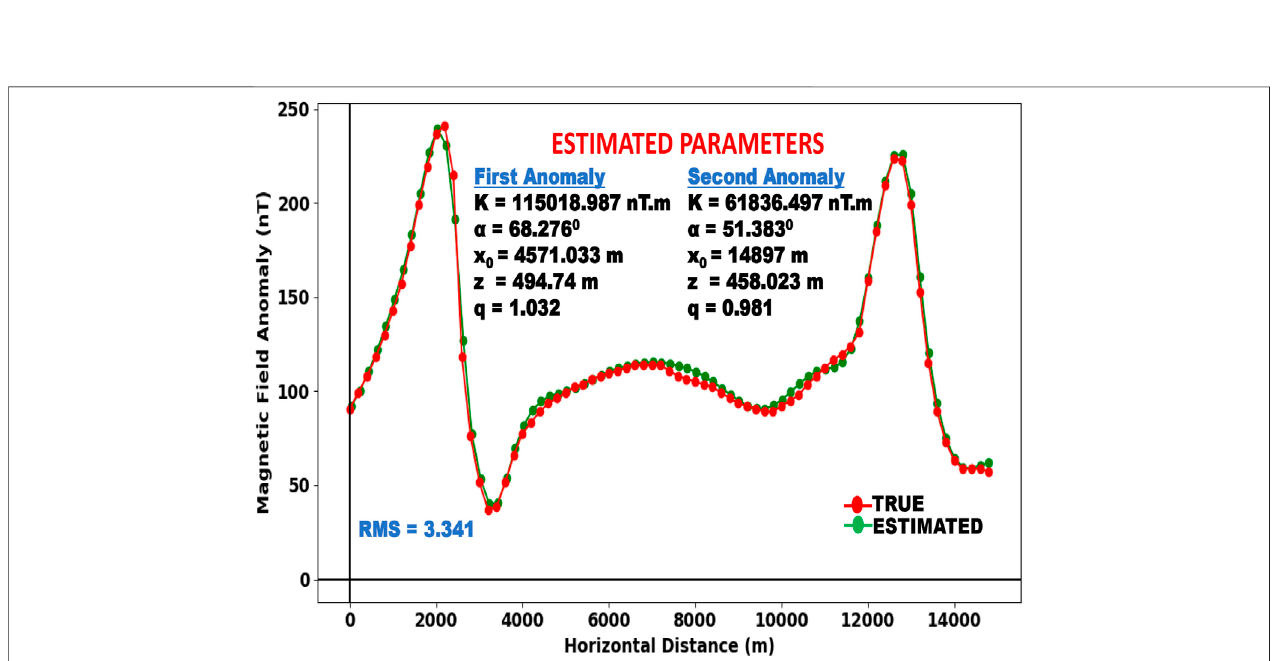
FIGURE 14 | Magnetic anomaly pro fi le over the Hamrawein fi eld anomaly using the MRF algorithm.